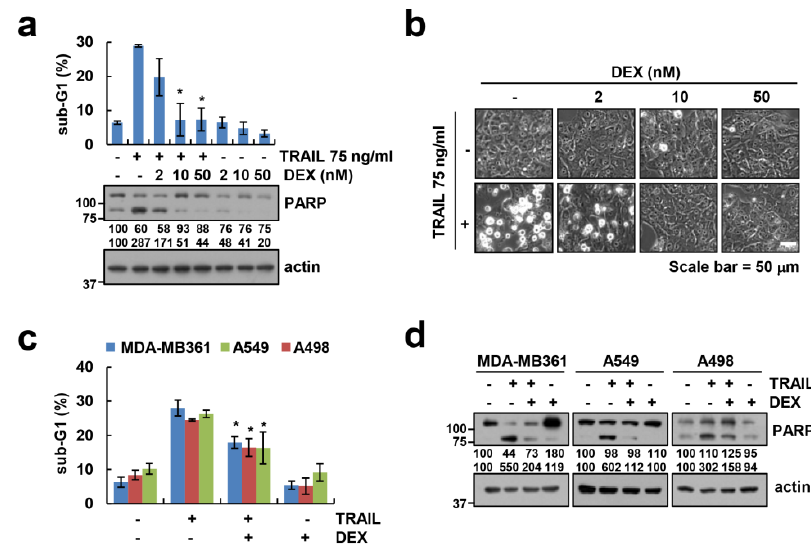
Figure 1. Dexamethasone (DEX) attenuates tumor necrosis factor-related apoptosis-inducing ligand (TRAIL)-induced apoptosis. ( a – d ) Caki-1 ( a , b ) and indicated cells ( c , d ) were treated with DEX for 1 h, and then added with 75 ng / mL TRAIL for 24 h. Apoptosis and protein expression were determined by flow cytometry ( a , c ) and Western blotting ( a , d ), respectively. Cell morphology was assessed using a light microscope ( b ). Values in the graphs ( a , c ) represent mean ± SD of three independent experiments. * p < 0.01 compared to TRAIL. Uncropped pictures of the western blot shown in the Supplementary Figure S3.